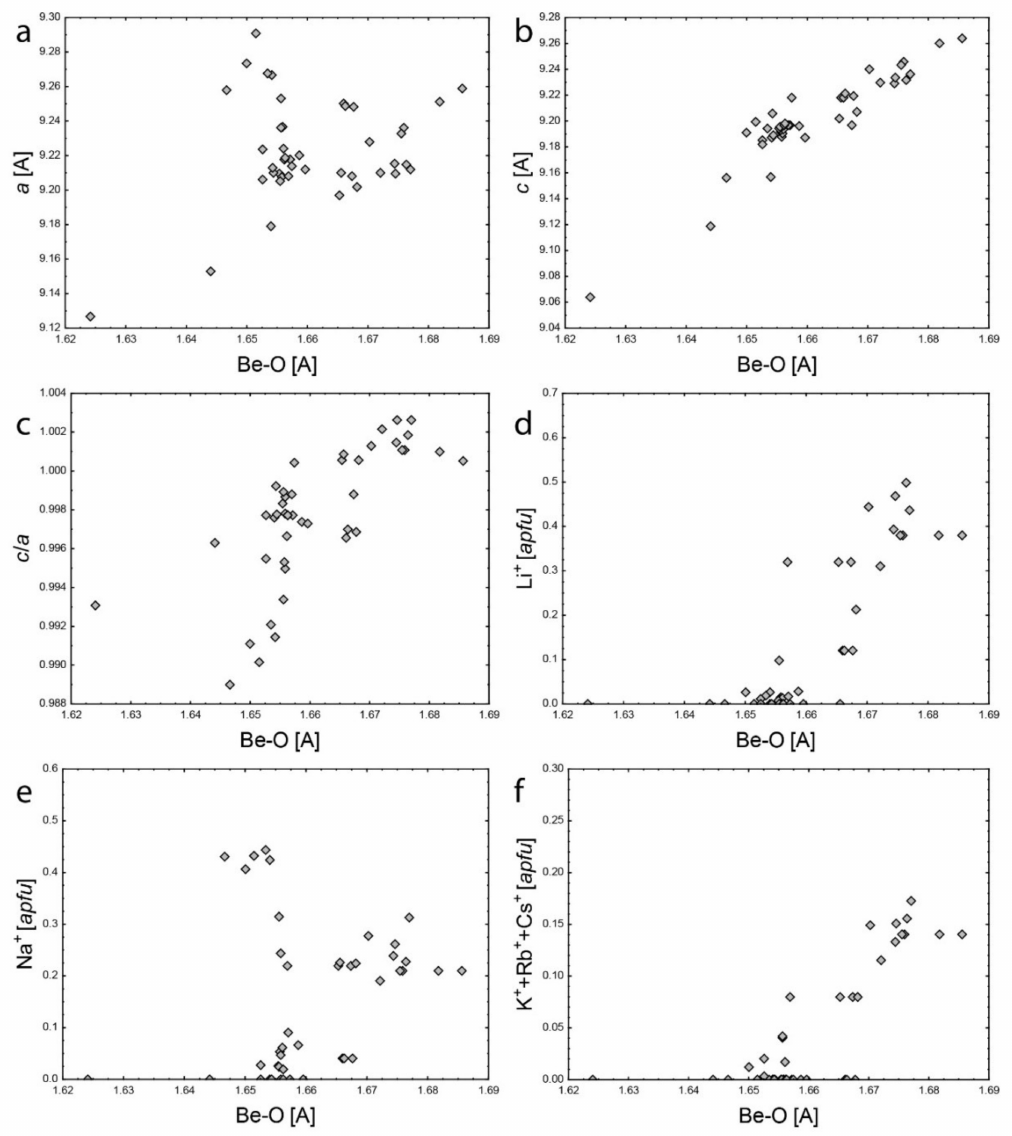
Figure 7. Comparison of Be 2 + –O bond length to: ( a ) a ; ( b ) c ; ( c ) c / a ; ( d ) Li + ; ( e ) Na + ; ( f ) K + + Rb + + Cs +